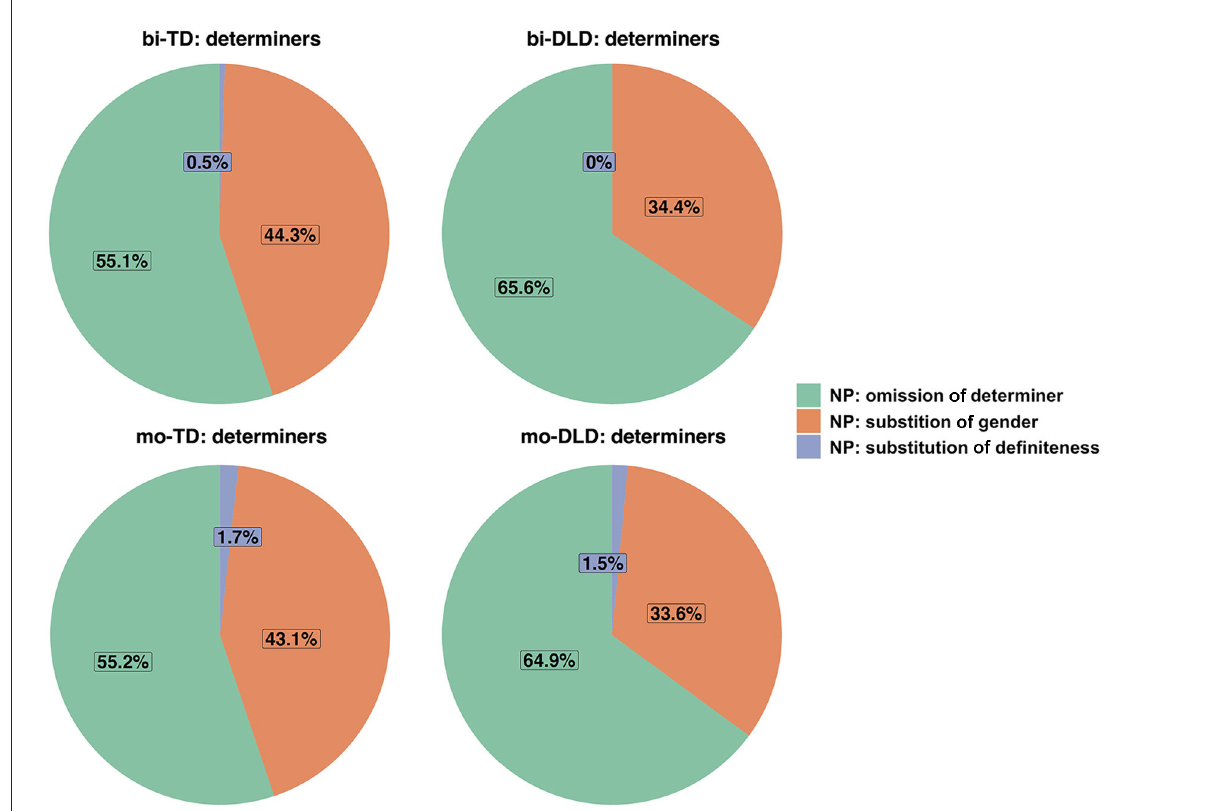
FIGURE5 Distributions of determiner errors in Dutch in the bi-TD, bi-DLD, mo-TD, and mo-DLD group.